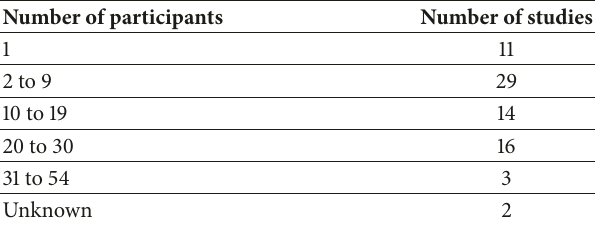
Table 12: Number of participants in each included